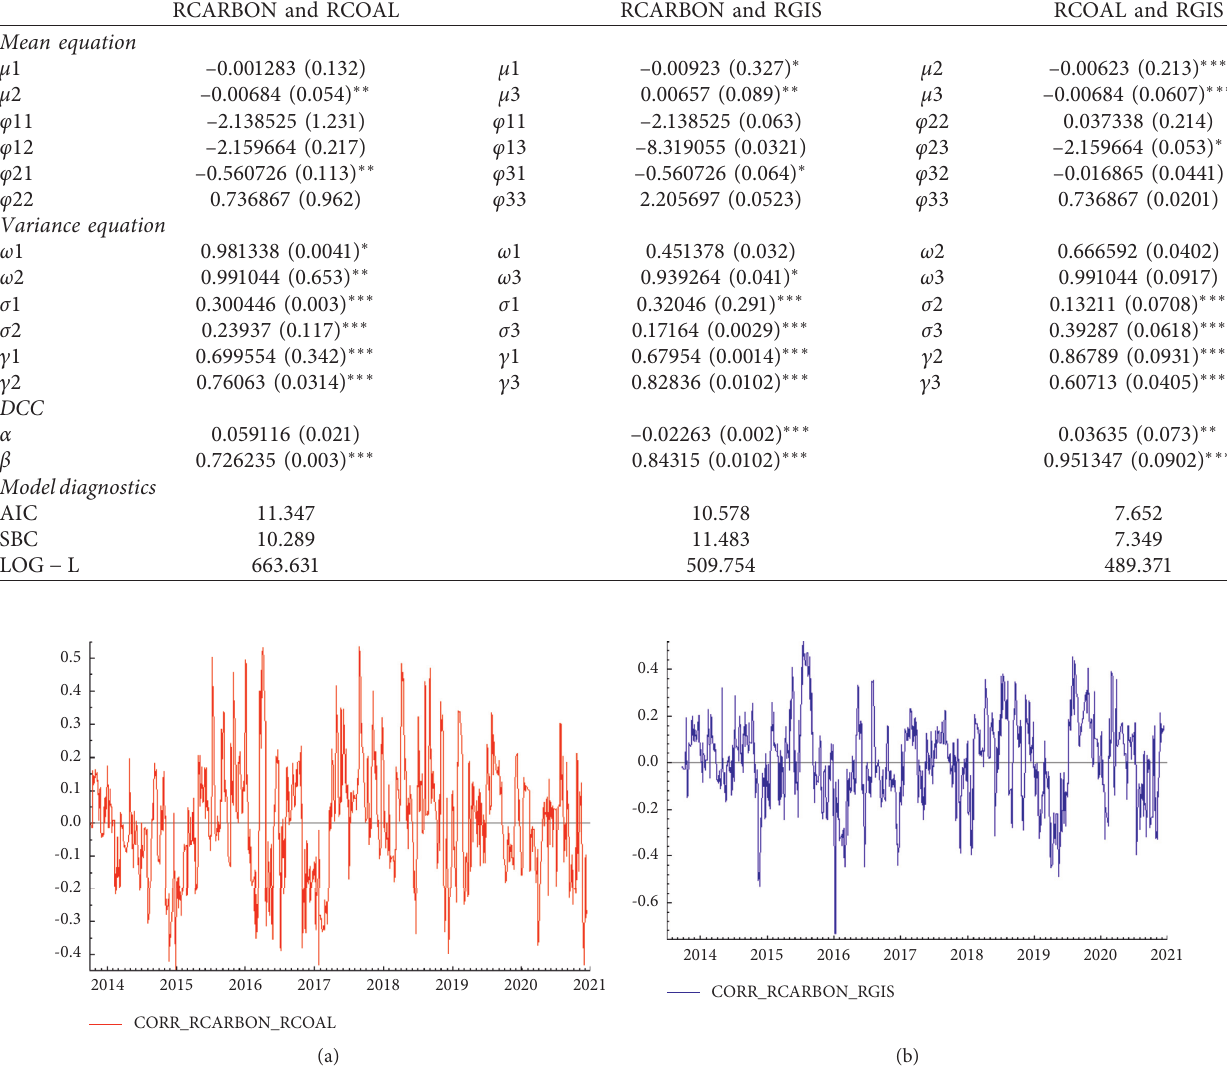
Table 6: Results of VAR-GARCH-DCC.